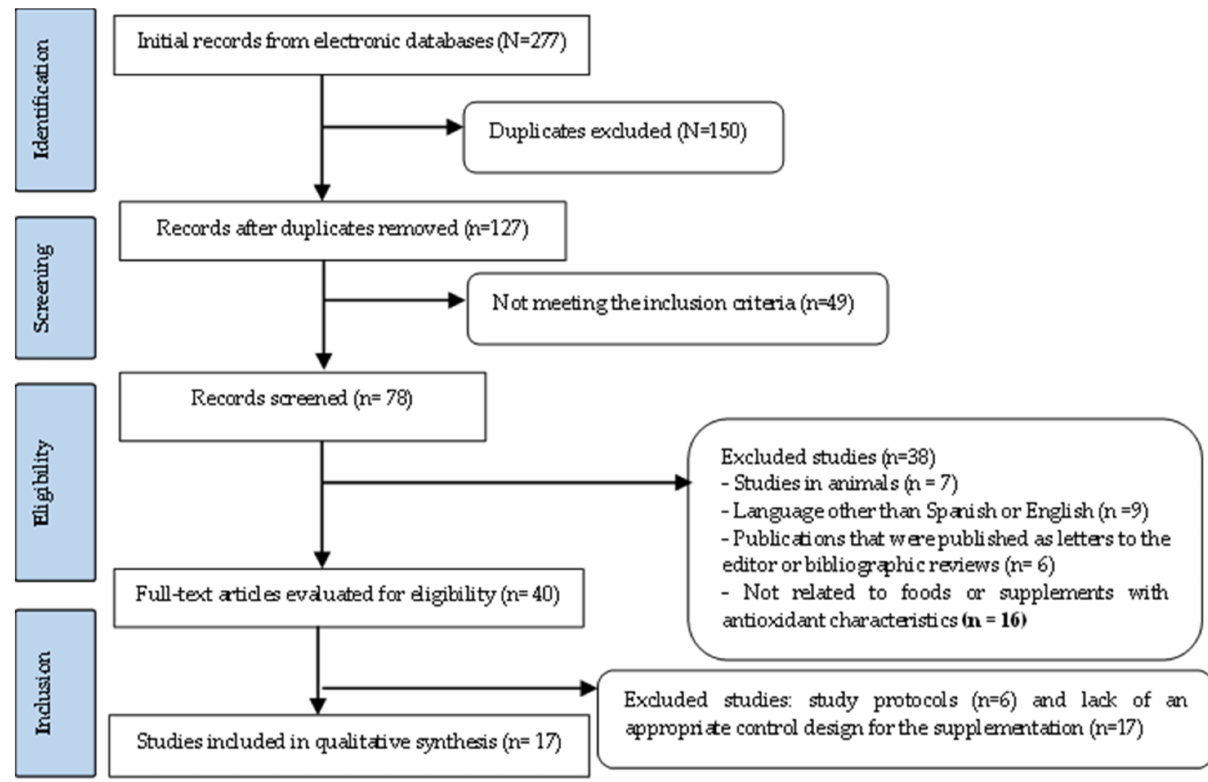
Figure 1. Flowchart for item